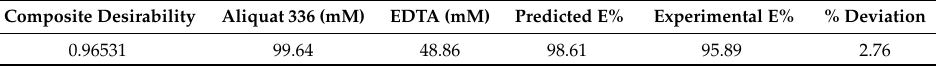
Table 7. Model validation with optimum operating conditions for the extraction of Cd(II). Composite